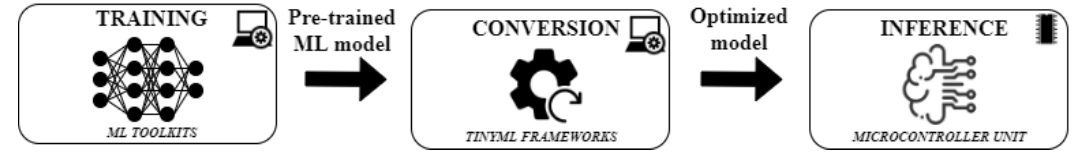
Figure 1. TinyML workflow.